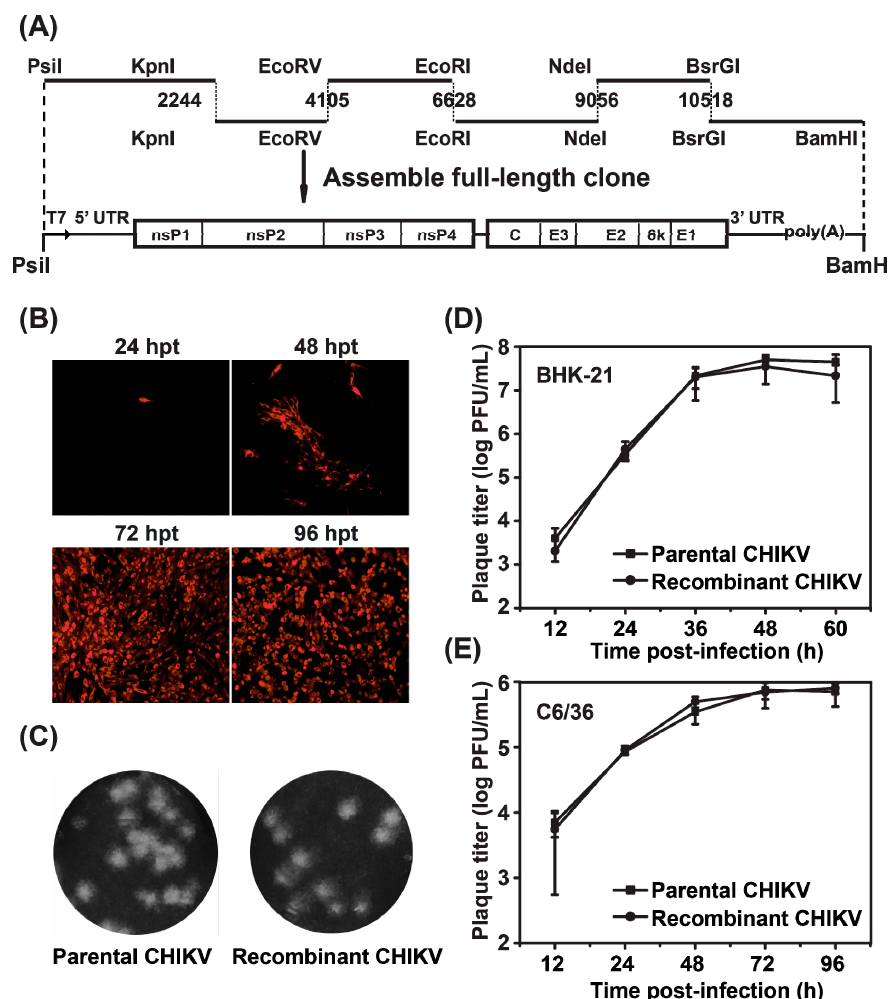
Figure 2. Construction and characterization of the full-length cDNA clone of CHIKV. ( a ) six cDNA fragments represented by thick lines were synthesized from genomic RNA through RT–PCR to cover the complete CHIKV genome and unique restriction sites as well as their nucleotide numbers are shown. Genome organization is depicted below. Individual fragments were assembled to form the full-length cDNA clone of CHIKV (pACYC-CHIKV). The complete CHIKV cDNA is under the control of T7 promoter elements for in vitro transcription. The numbers are the nucleotide positions based on the CHIKV genome sequences we identified in this study (KC488650); ( b ) IFA of viral protein expression in BHK-21 cells transfected with the full-length CHIKV RNA transcript. The transfected cells were analyzed by IFA at the indicated time points post-transfection; ( c ) plaque morphology of parental and recombinant CHIKV on BHK-21 cells; ( d , e ) comparison of the growth kinetics of recombinant and parental CHIKV in BHK-21 and C6/36 cells, respectively. The virus growth curves were compared at MOI = 0.1 on both cells. Three independent experiments were performed in duplicate, and the representative data were presented.